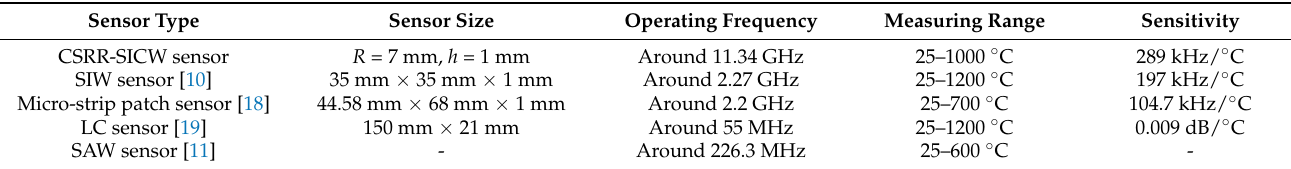
Table 3. Parameters comparison of different types of temperature